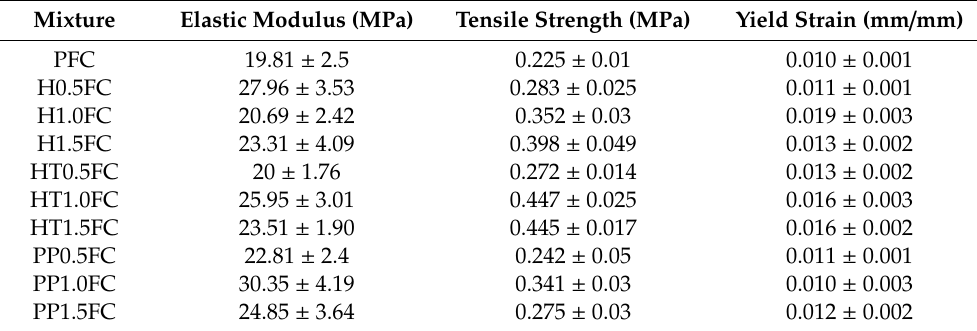
Table 5. Uniaxial tensile test results.